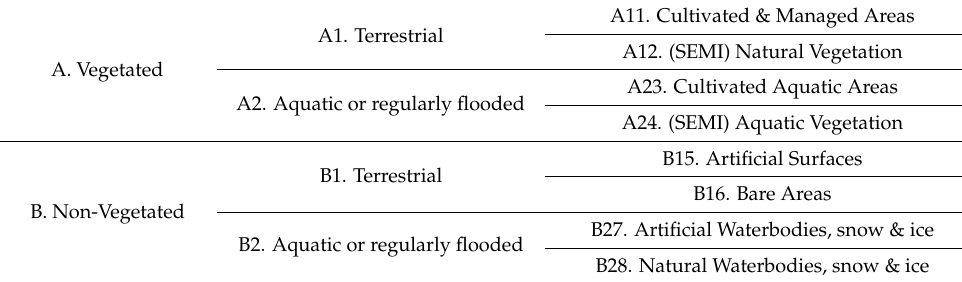
Table 2. Basic Architecture of FAO/UNEP LCCS Phase